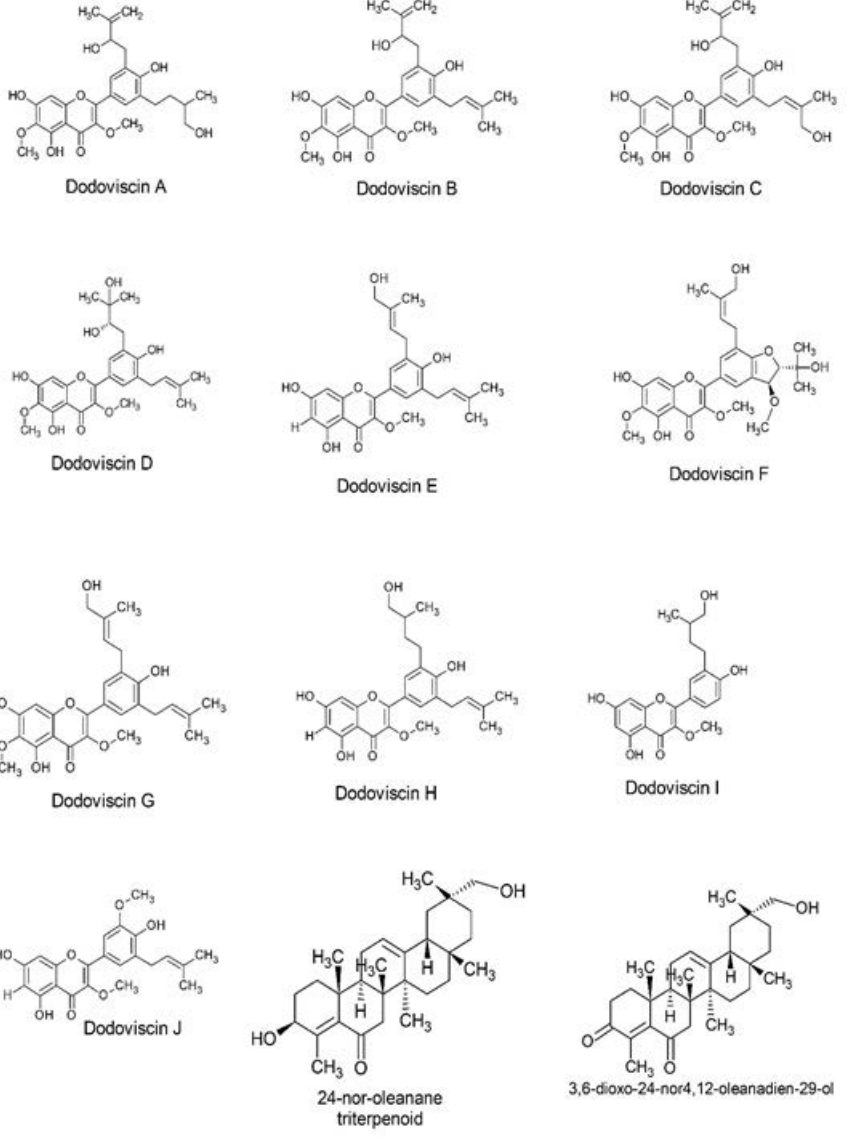
Fig. 2b. Chemical constituents reported in Dodonaea viscosa Jacq